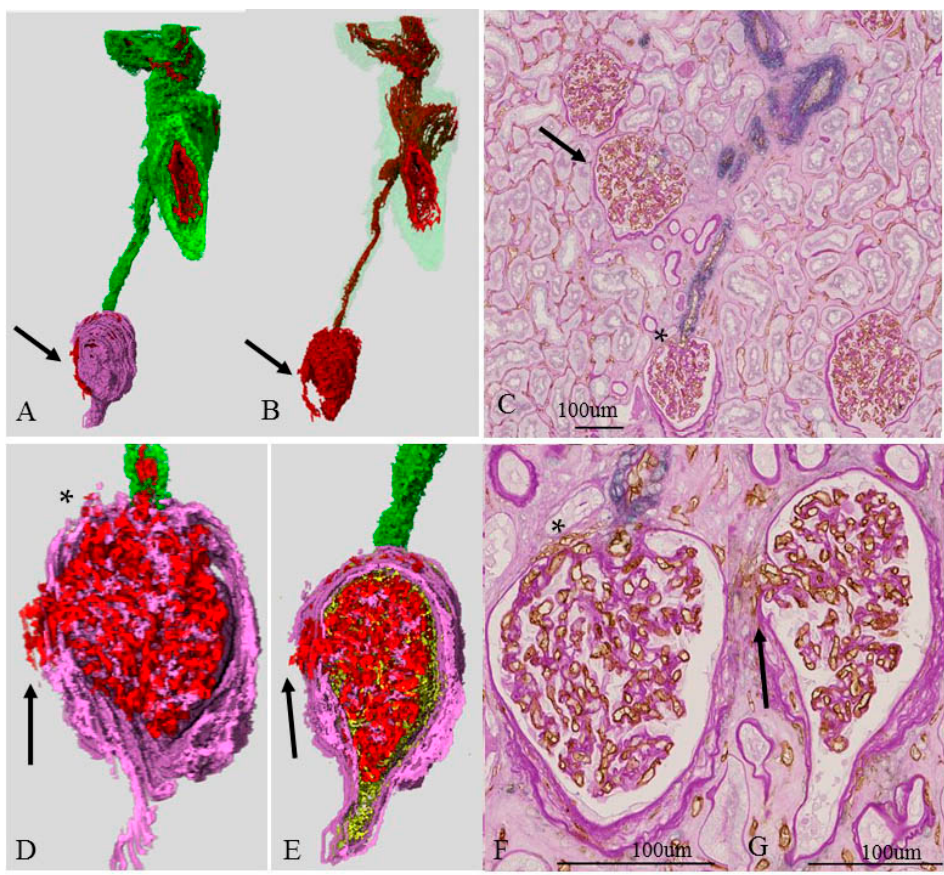
Figure 5. Three-and two- dimensional image of atubular glomerulus (Case 3). ( A , B , D , E ) 3D image of an atubular glomerulus with the interlobular artery and the afferent artery. Red , green , pink , and yellow represent CD34-positive endothelial cells, SMA-positive smooth muscle cells, PAS-positive basement membranes of the Bowman capsule and glomerulus, and epithelial cells of the glomerulus, Bowman’s capsule, and proximal tubule, respectively. These structures correspond to * in Figure 3A,C–F. ( C , F , G ) 2D image double-immunostained with anti-CD34 ( brown ) and SMA ( blue ) and then PAS stain. The interlobular artery has a large lumen ( C ). The afferent arteriole is long and has small lumen ( B , C ). The glomerulus (*) ( C ) corresponds to ( A , B , D – G ). The glomerulus (*) is smaller than the other glomerulus (arrow) ( C ) and shows shrinkage of the tuft ( F , G ); and the glomerulus has two exits (* and arrow) ( D – G ).